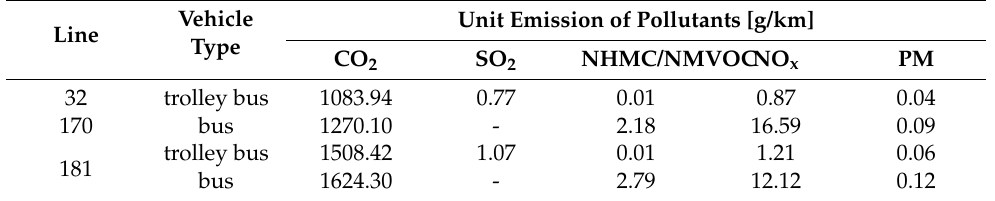
Table 5. Unit emission of pollutants from means of public transport on the analysed